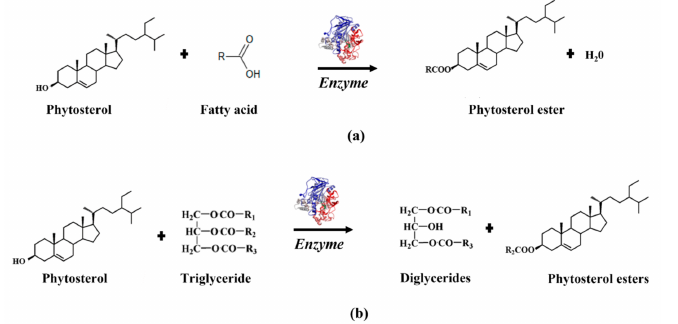
Figure 4. Synthesis of phytosterol esters by direct esterification to free fatty acids ( a ) and transesterifi- cation with triacylglycerols ( b ) in the presence of a biological